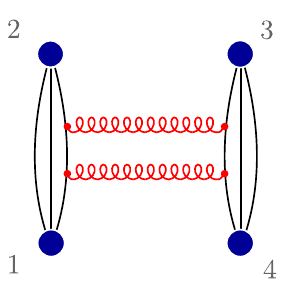
Figure 12 . At two loops, we expect some of the graphs which did not contribute at lower orders to appear, as they have a leading-order colour factor. One such example is the graph depicted, which is disconnected at